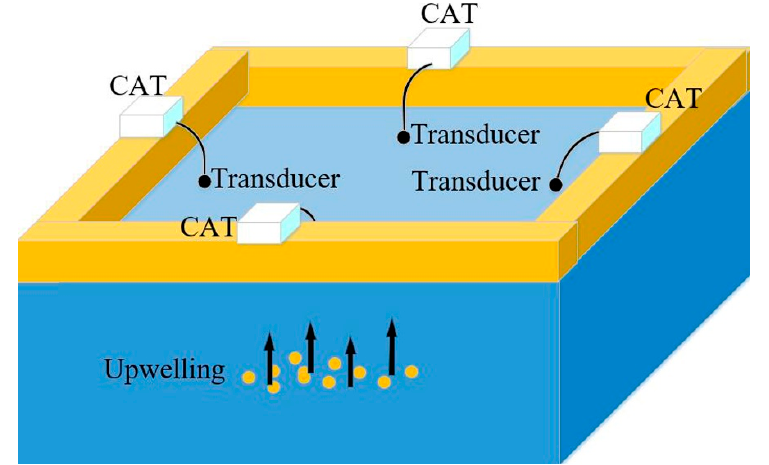
Figure 3. Experiment arrangement.